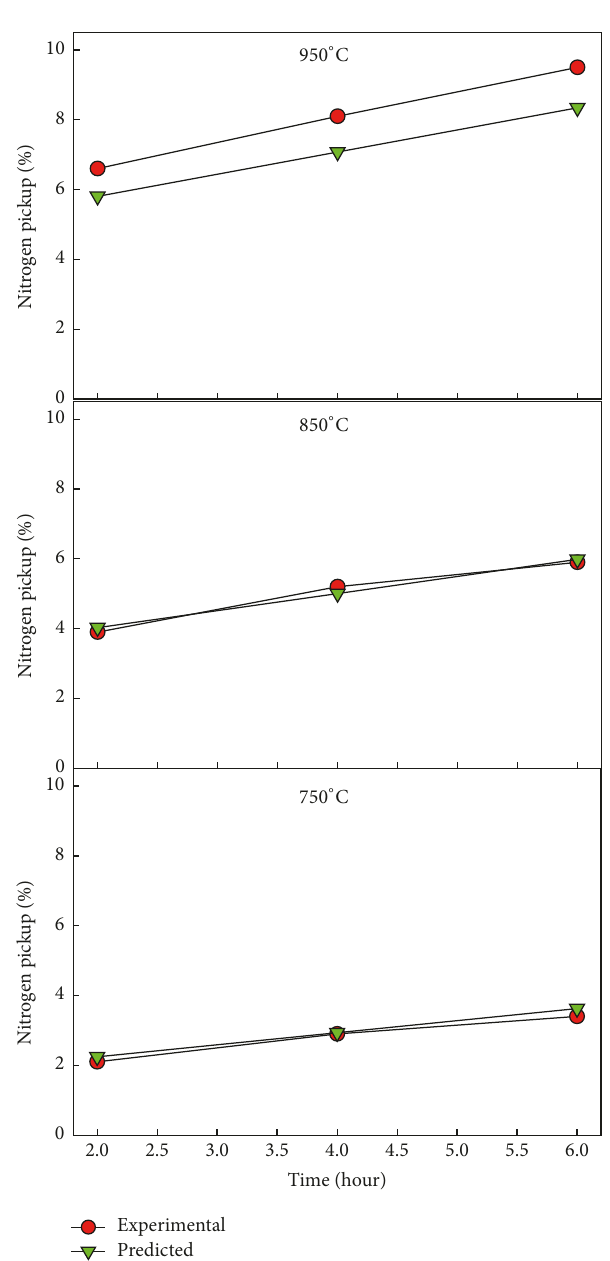
Figure 4: Variation between the predicted and published nitrogen pickup of medium carbon (1.2% C) ferromanganese at 8bar and at different time and temperature [10,